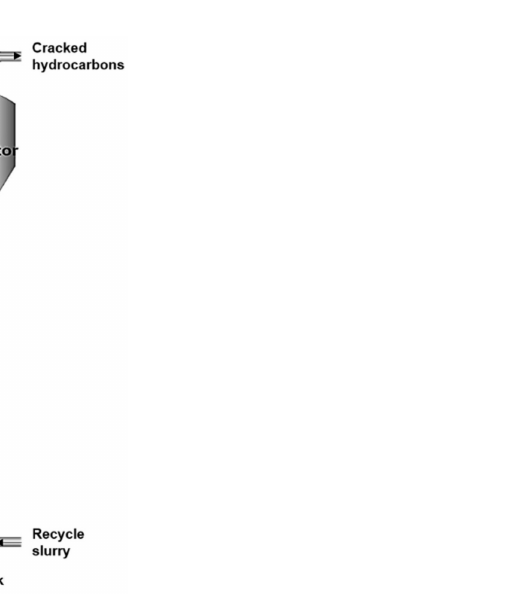
Figure 1. The FCC unit regenerator as well as the associated catalyst logistic streams are schemati- cally